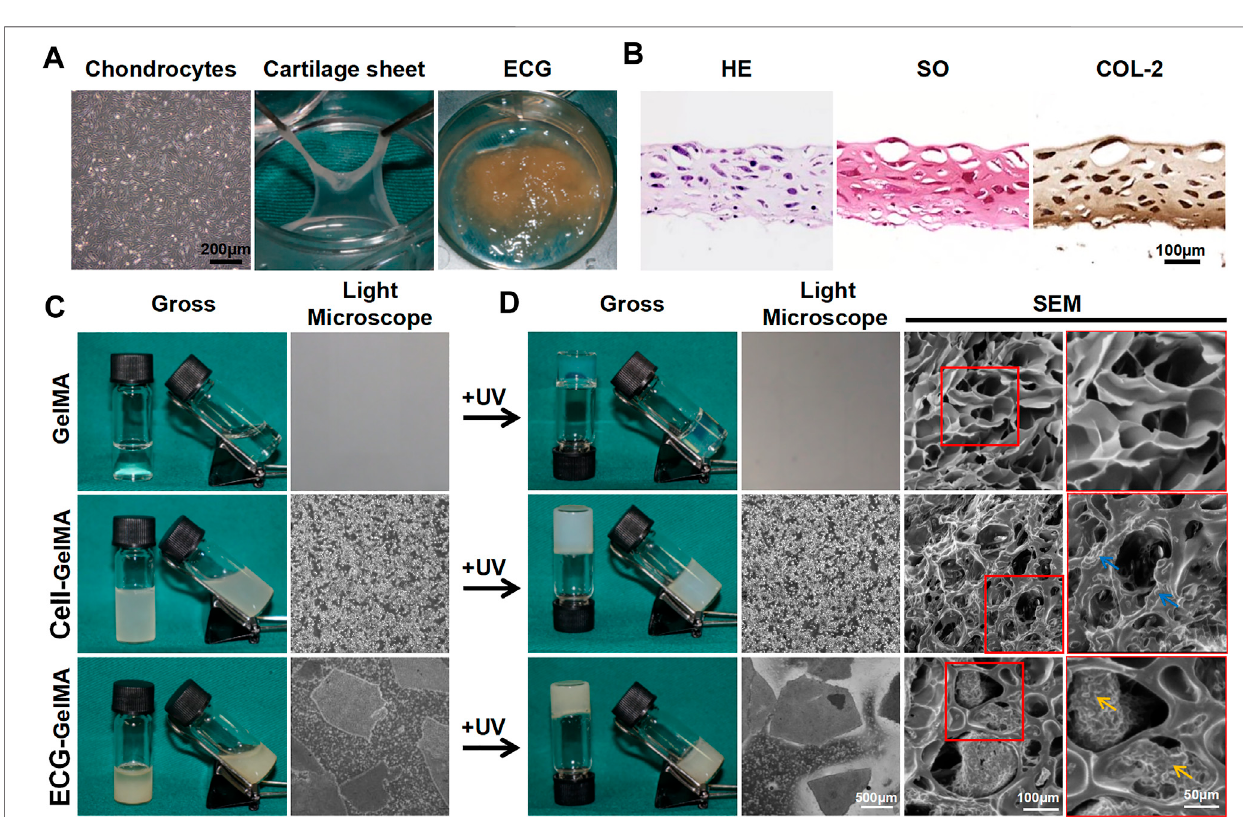
FIGURE1| ThesynthesisandgelpropertiesofECG-GelMA.ThelightmicroscopeimageofchondrocytesatP3,grossimageofcartilagesheetafter5 days invitro cultured,andgrossimageofECGderivedfromchoppedcartilagesheet (A) .HE,SO,andCOL-2stainingofcartilagesheet (B) .Thegrossandlightmicroscopeimagesof GelMA, Cell-GelMA, and ECG-GelMA before UV crosslinking (C) . The gross, light microscope, and SEM images of GelMA, Cell-GelMA, and ECG-GelMA after UV crosslinking (D) . The blue arrows indicate cells, and the orange arrows indicate ECG.